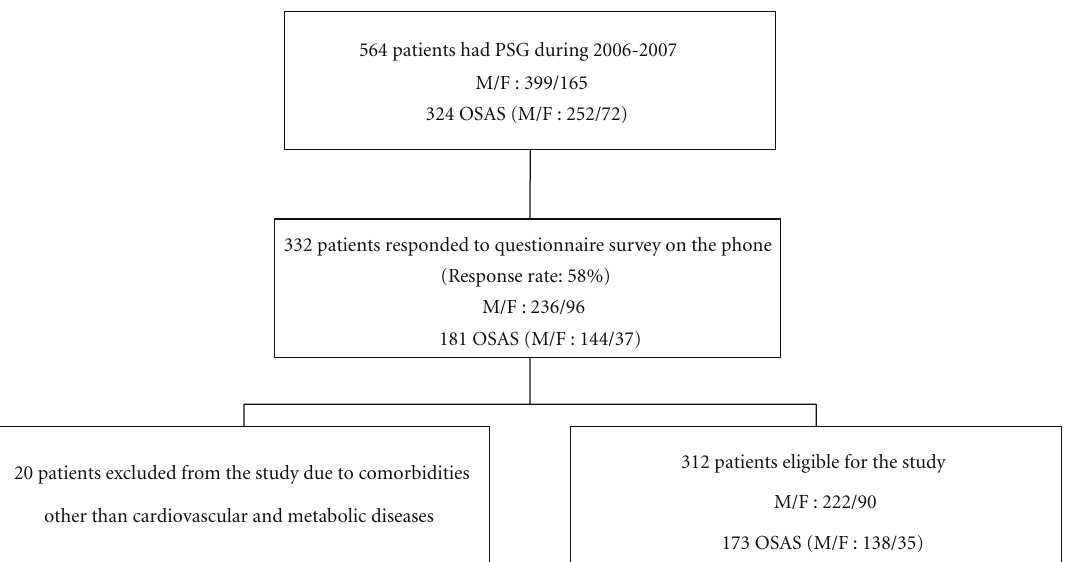
Figure 1: Flowchart of the study, describing the study population: PSG: polysomnography, M: male, F: female, OSAS: obstructive sleep apnea syndrome defined as excessive daytime sleepiness (Epworth Sleepiness Scale score > 10) and AHI (apnea-hypopnea index) ≥ 5 or AHI ≥ 15, regardless of excessive daytime